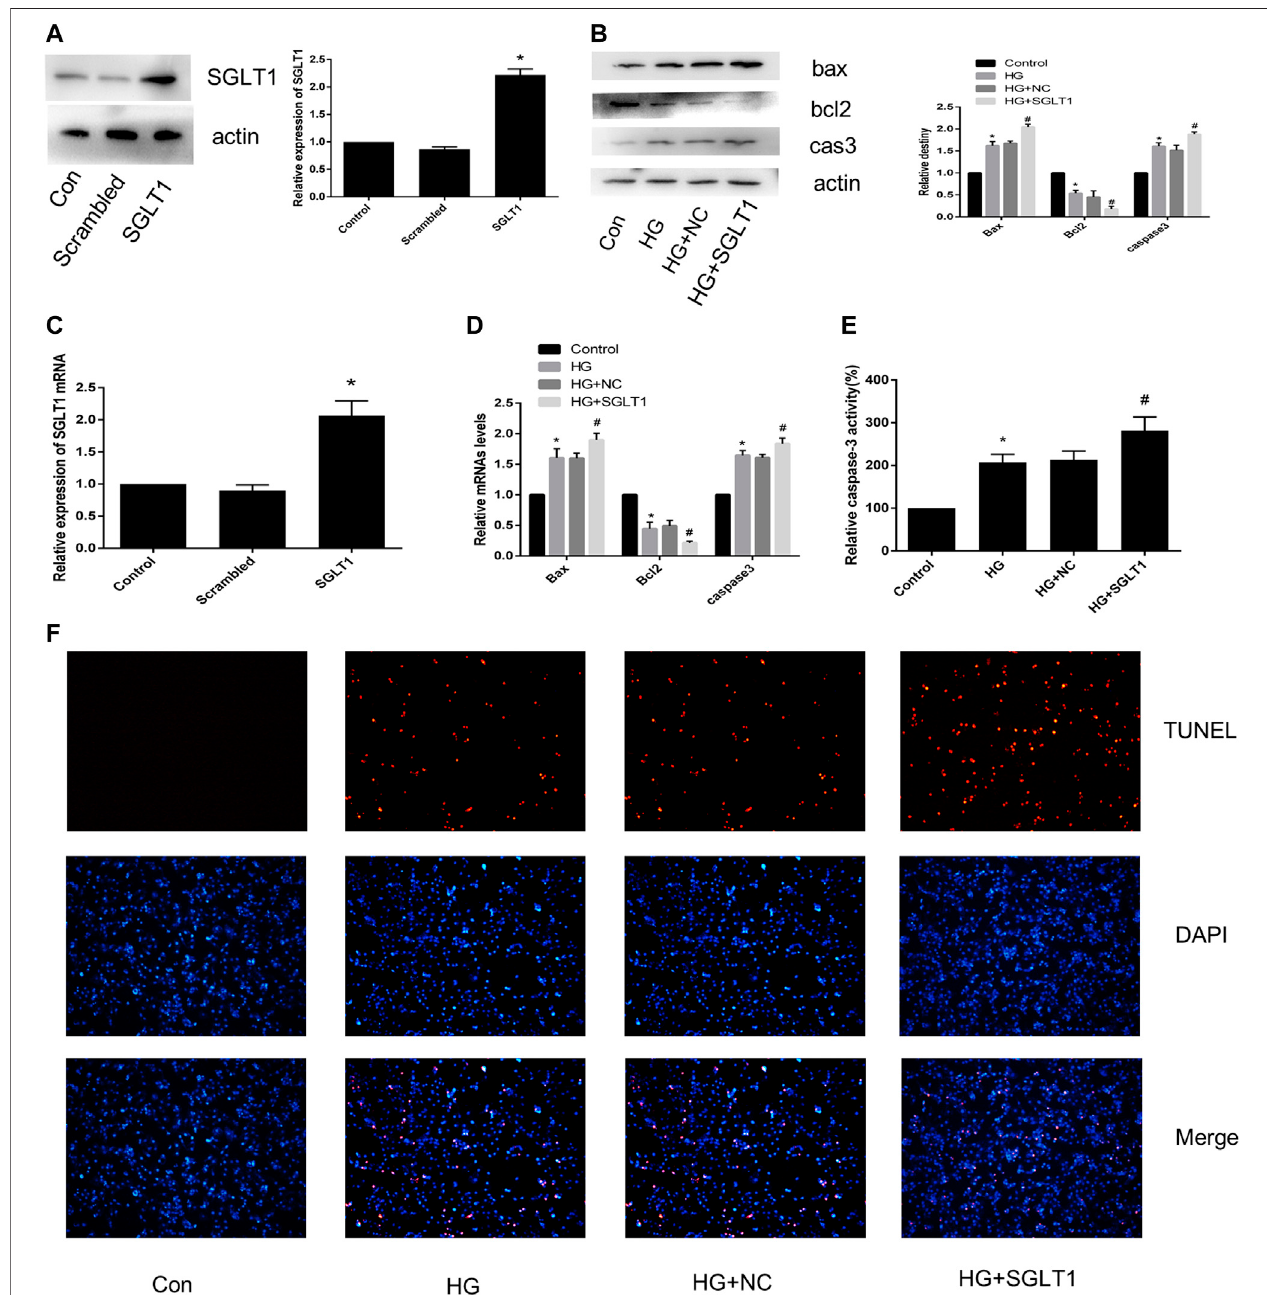
FIGURE 7 | SGLT1 upregulation aggravated apoptosis induced by HG. (A) SGLT1 protein expression following successfultransfection of SGLT1 into H9C2 cells. (B) RT-PCR analysisof SGLT1. (C) The expression of apoptosis-related speci fi c markers (bax, bcl2, caspase-3). (D) Relative mRNA levels of bax, bcl2, and caspase-3. (E) Caspase-3activityinH9C2cells. (F) ApoptoticrateofH9C2cellsmeasuredbyTUNELstaining.* p < 0.05comparedwiththecontrolgroup; # p < 0.05comparedwith HG group. Experiments were performed in triplicate.